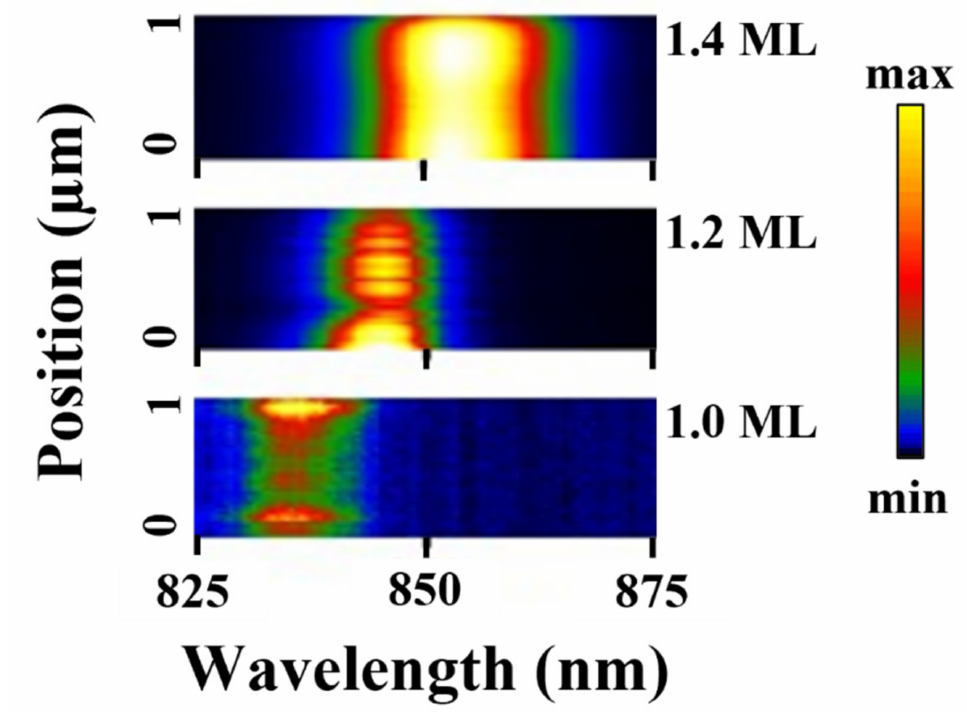
Figure 7. CL spectrum images of samples with 1.0 ML, 1.2 ML, and 1.4 ML InAs layers, respectively. All results are obtained by scanning the beam alone a line of 1 µ m. The step size is 50